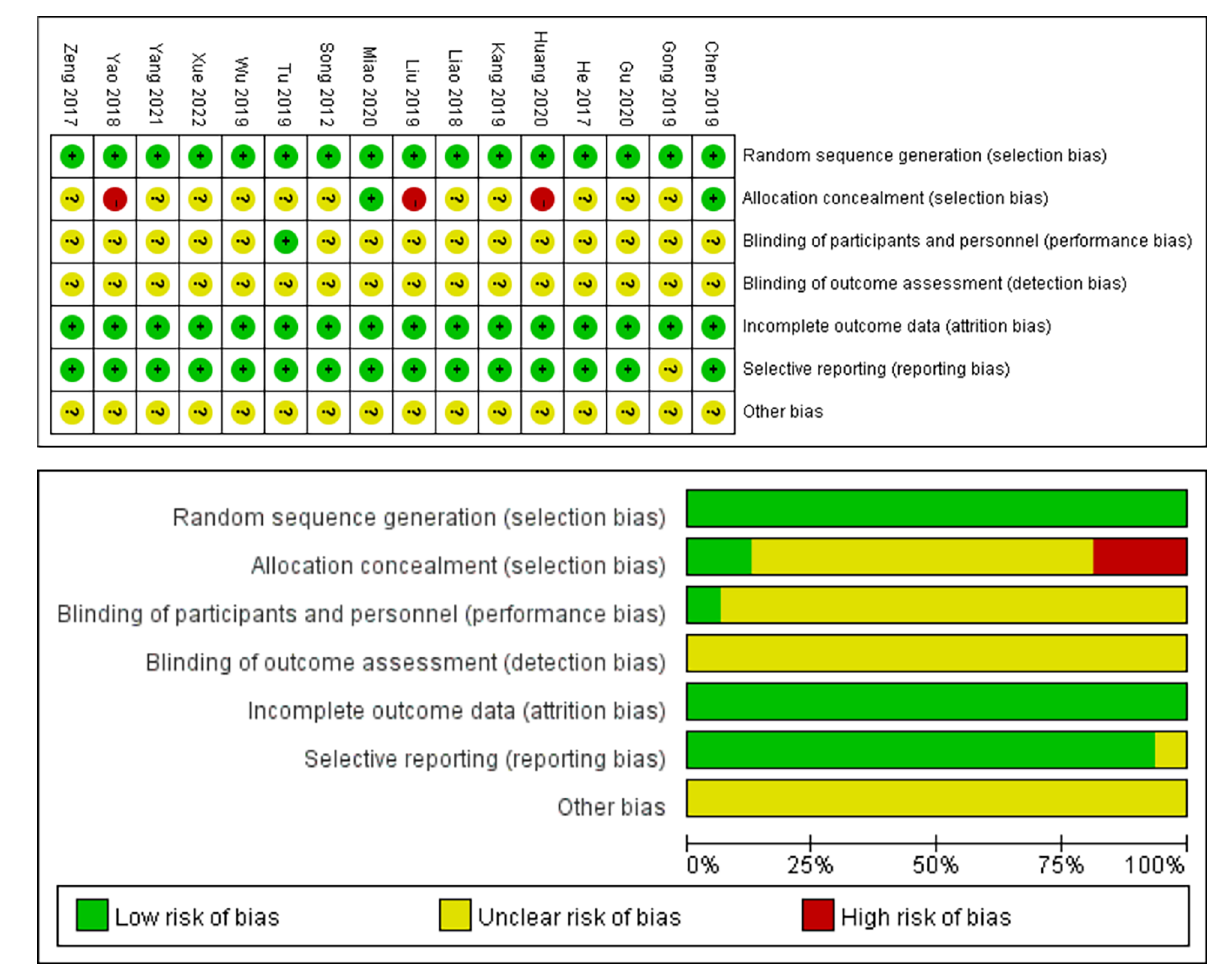
FIGURE 2 Quality assessment of